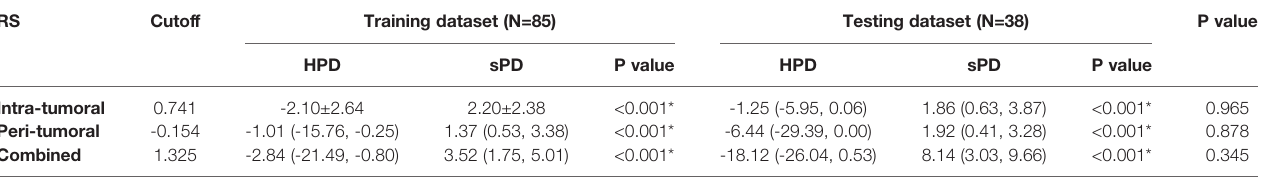
TABLE 3-3 | The distribution of the radiomics scores for HPD vs sPD in the training and testing datasets. RS